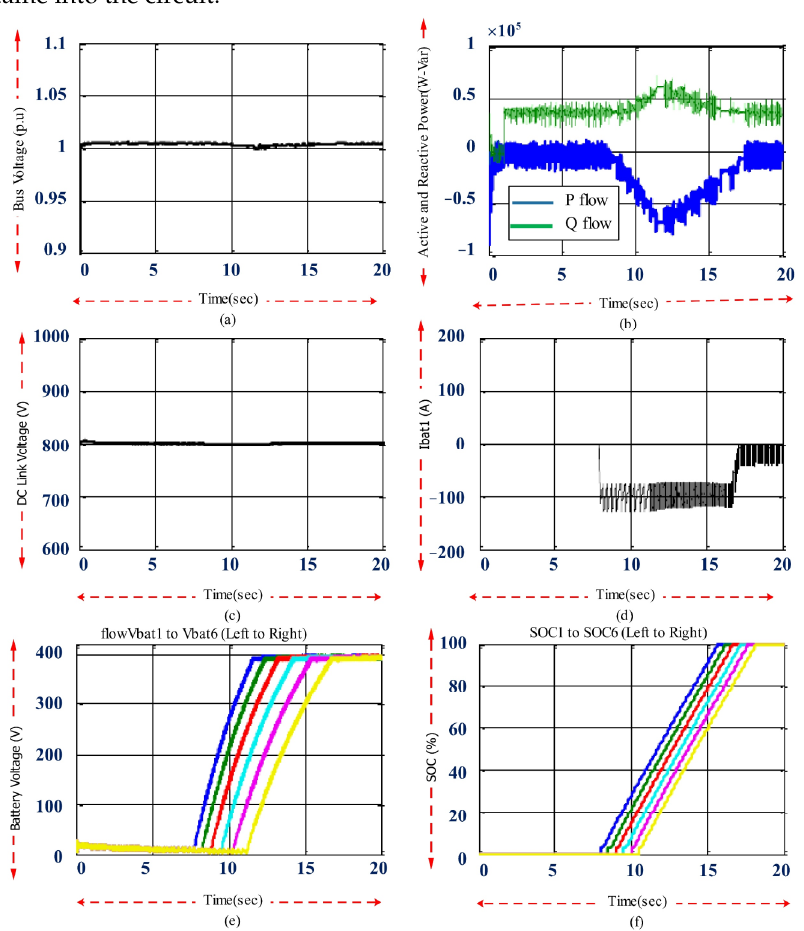
Figure 16. EV fast charging results with reactive power compensation control at a bus voltage of 0.96 p.u. ( a ) Bus voltage; ( b ) active and reactive power exchange; ( c ) DC link voltage; ( d ) battery current; ( e ) battery voltage; ( f ) SOC.